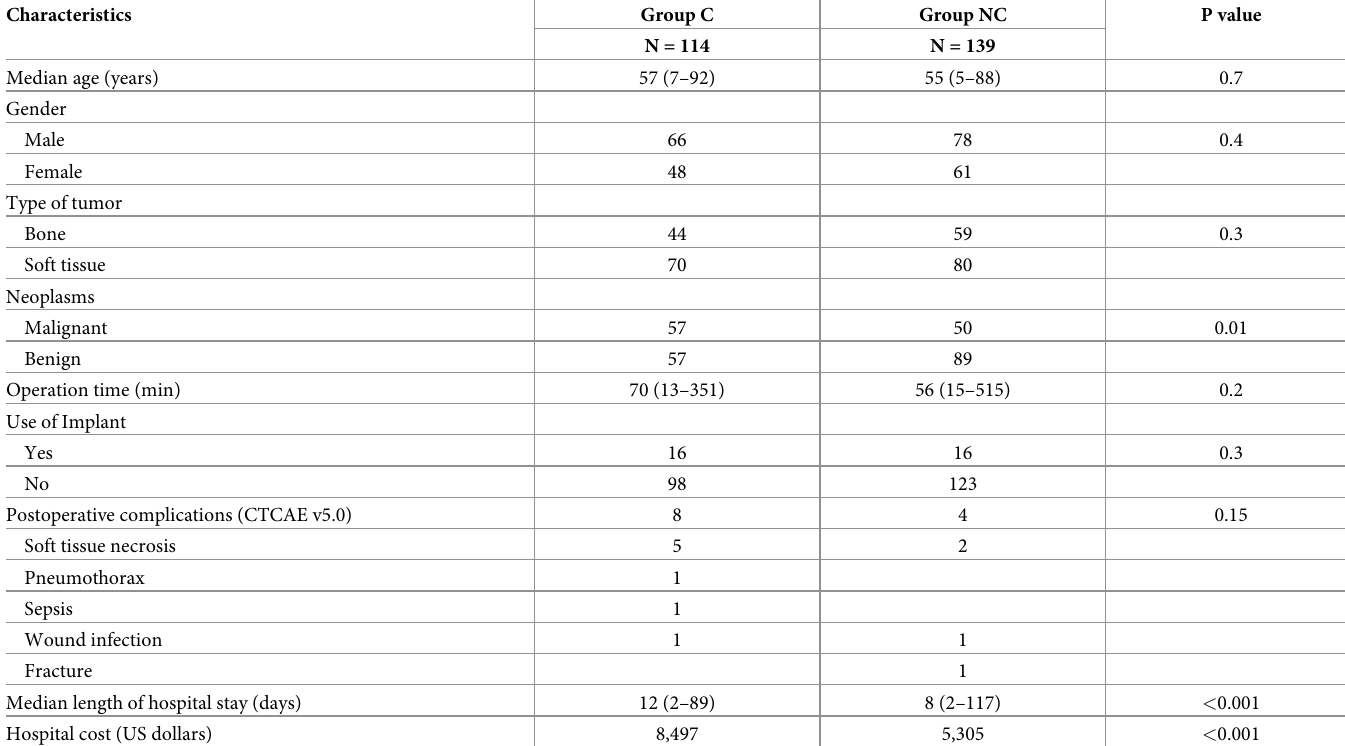
Table 1. Comparison of clinical information of corona era vs no corona era for